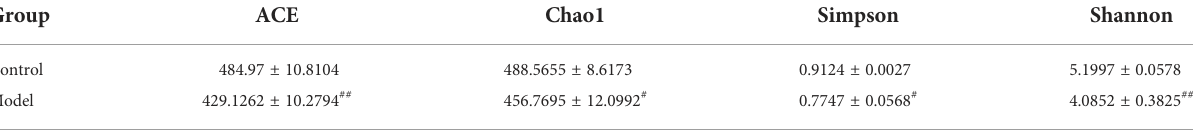
TABLE 1 Alpha diversity index analysis of fecal mycobiota of Cynomolgus macaques ( (cid:1) X SEM).